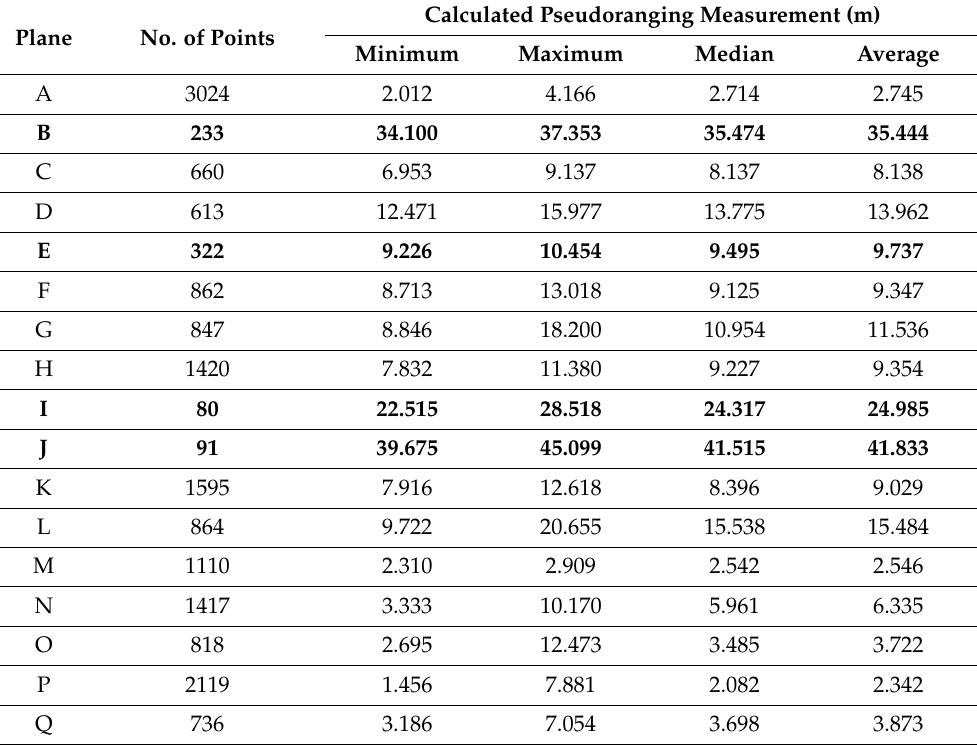
Table 6. The statistics of pseudoranging measurements in each plane for dataset DATA1. Calculated Pseudoranging Measurement Plane No. of Points